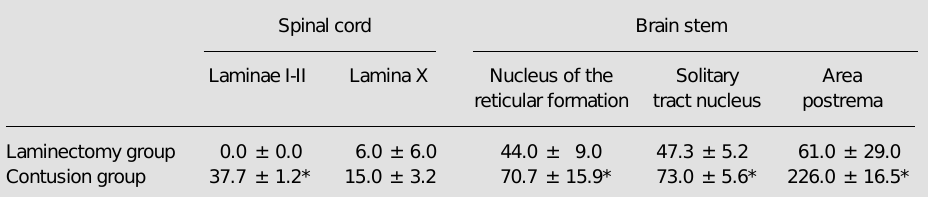
Spinal cord Brain stem Lamina X Nucleus of the